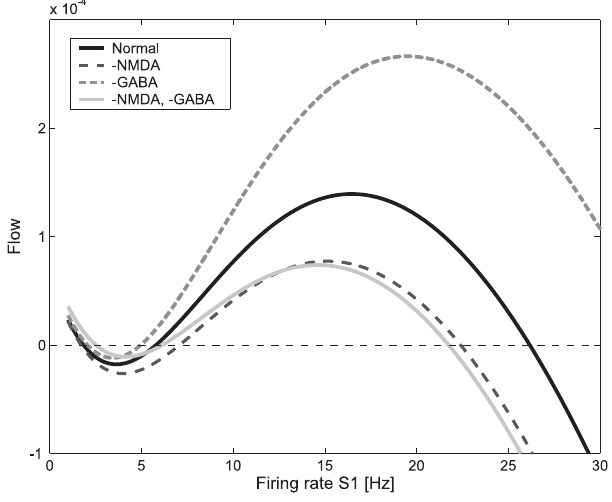
Figure 1. Flow of a Single-Attractor Network We assess the flow of an attractor network with one selective pool using the mean-field analysis for different modifications of synaptic conduc- tances (see Methods section). The flow represents the force which drives the system toward one of the stable attractors. The stable/unstable attractor states are at crossings with the flow ¼ 0 value on the flow axis with a negative/positive derivative, respectively. A modulation of the synapses labelled as ( (cid:2) NMDA) and ( (cid:2) GABA) corresponds to a reduction of 4.5% and 9% of the efficacies, respectively. A pool cohesion of w þ ¼ 1.6 and a selective pool size of 80 neurons were used for the simulations.